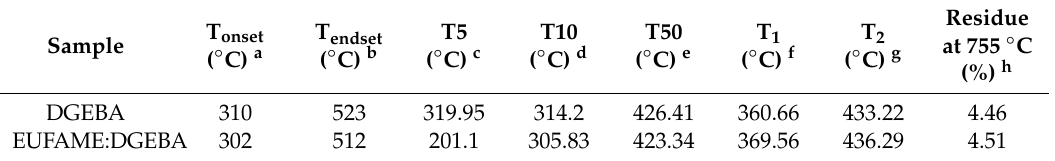
Table 5. Thermal degradation behaviors for cured neat epoxy resin (DGEBA) and cured EUFAME / DGEBA blend.